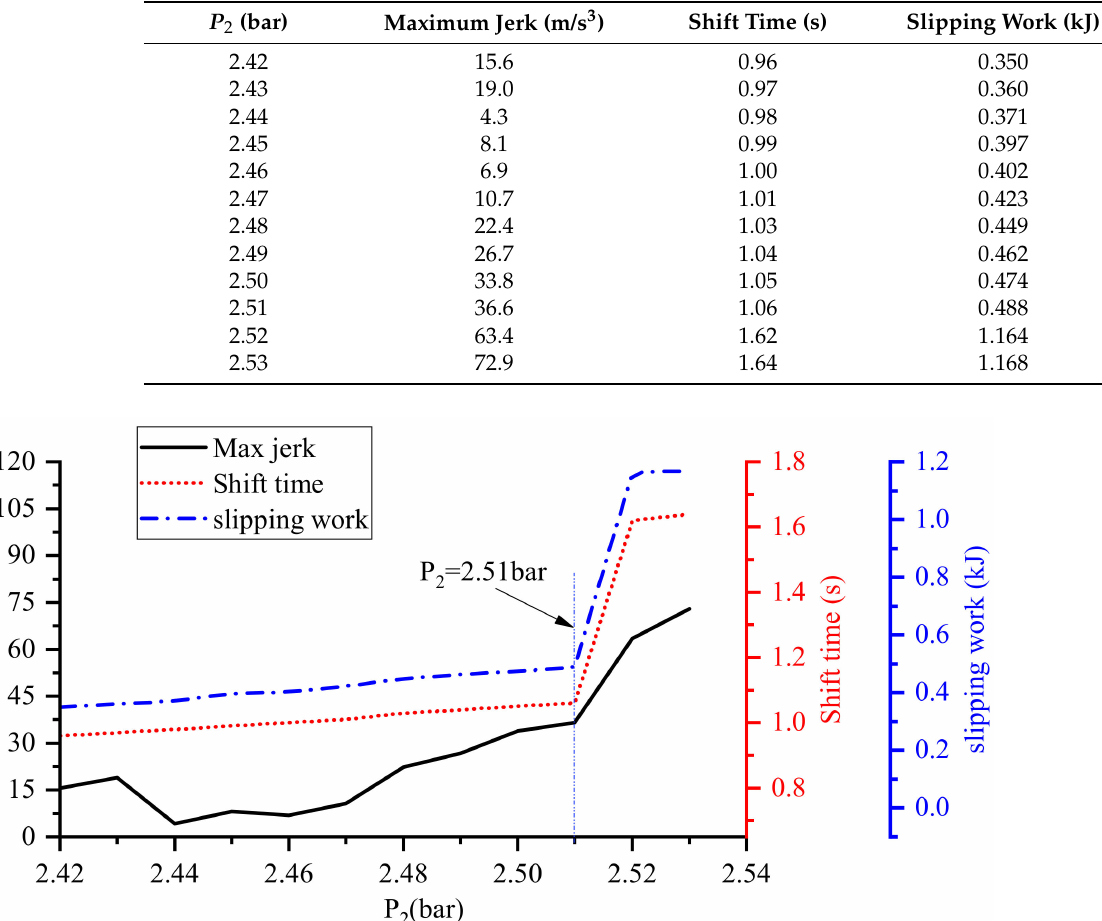
Table 1. Shift evaluating the indexes under different P 2 .